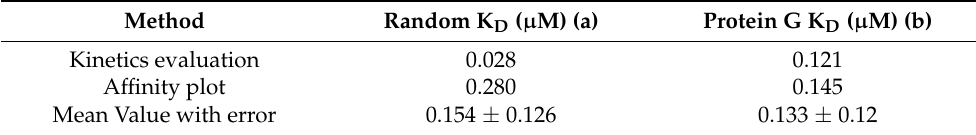
Table 1. Biomolecular binding affinities of horse heart MG determined by